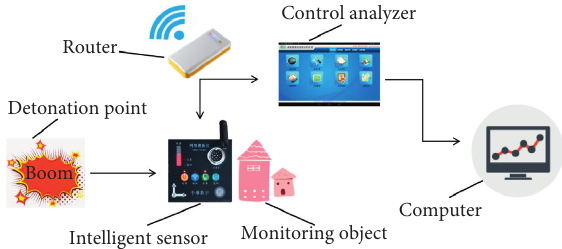
Figure 4: Blasting vibration testing